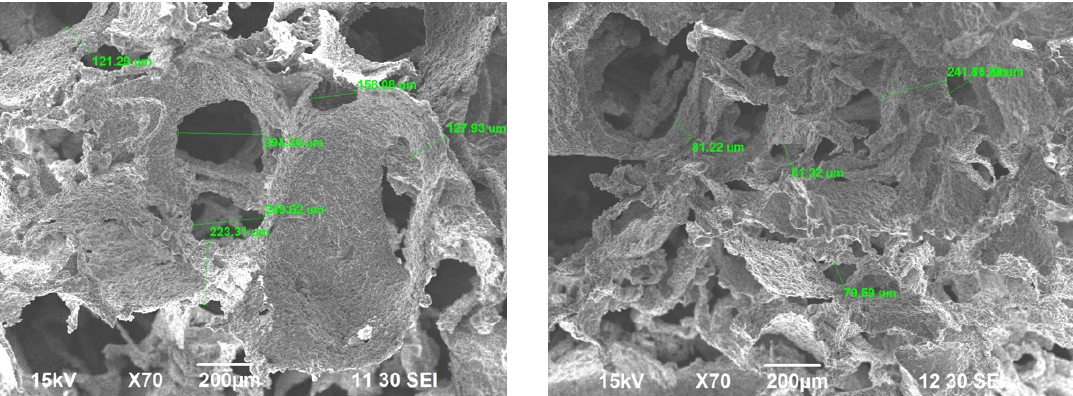
Figure 3. SEM image of BG scaffold. The porous structure is visible in the images. The green labels indicate pore measurements.